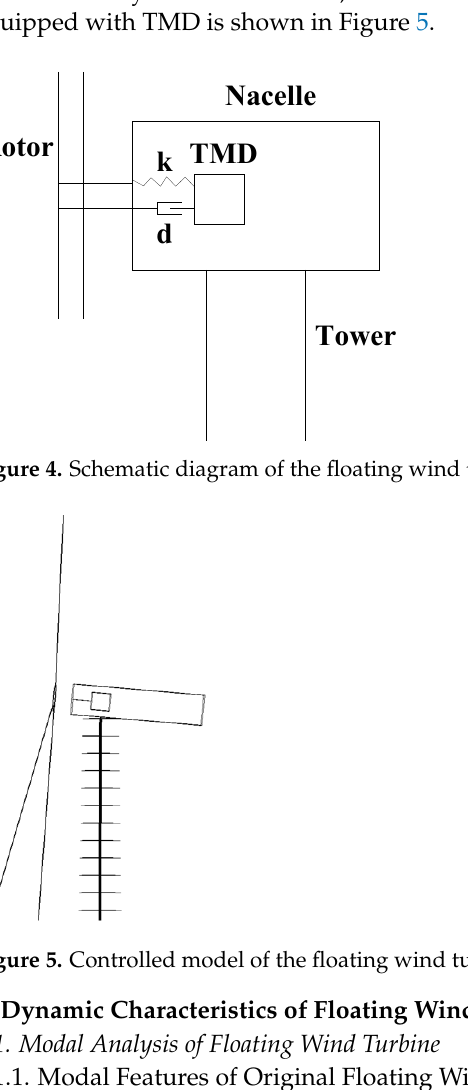
Table 8. The first 20 modes of the original wind turbine.